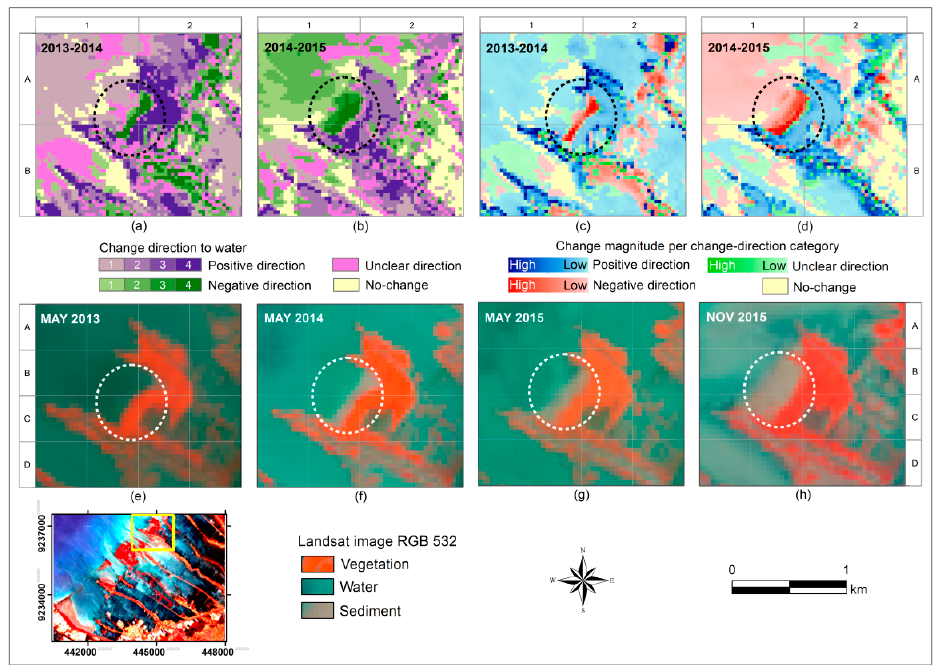
Figure 13. Water membership changes showing a continuous change to negative direction (see dark green pixels in black-dashed circles in ( a , b )) with high change magnitude (see dark red pixels in black-dashed circle in ( c , d )). RGB 542 of Landsat images show an increase of sediment and mangrove coverage from 2013 to 2015 (see white-dashed circle in ( e – h )).